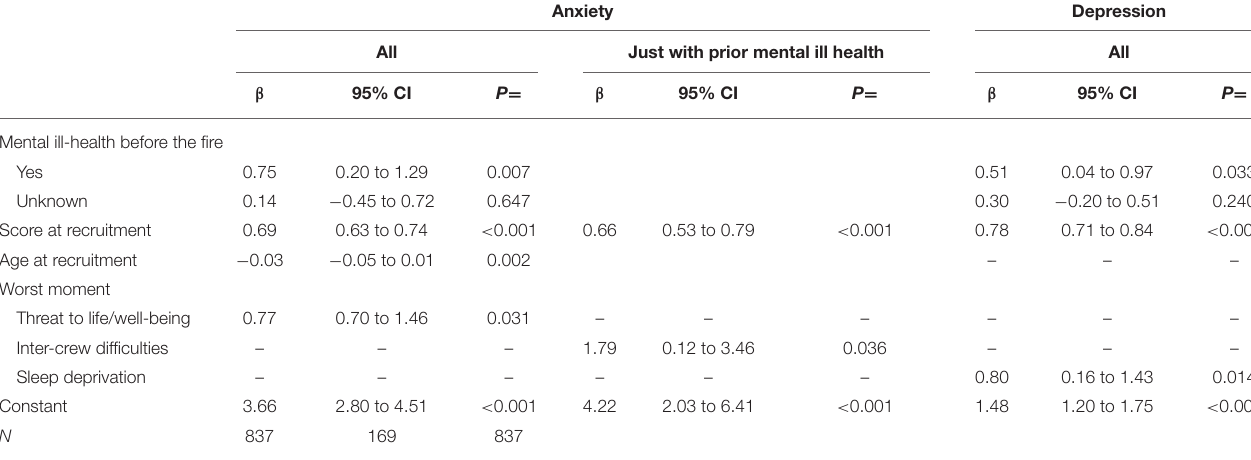
TABLE 9 | Final models for anxiety and depression at second follow-up, with worst moment allowing for anxiety or depression score at recruitment.